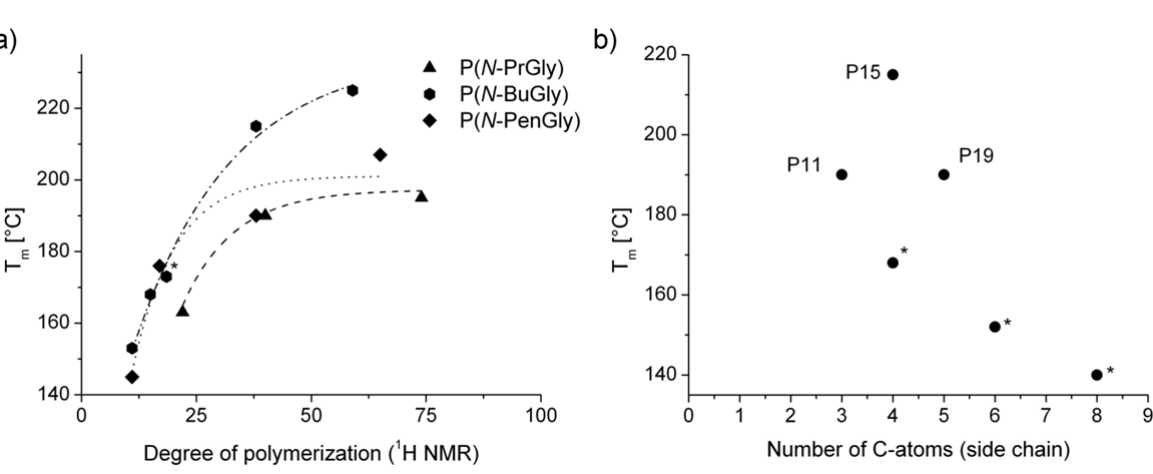
) as a function of ( a ) the degree m